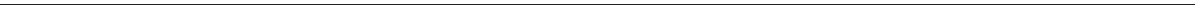
FIGURE 1 | mice are shown in blue and Tgfbr1 M318R / + are shown in yellow. The number of animals per group is indicated. P -values refer to Brown-Forsythe ANOVA, followed by post-hoc test with multiple comparison FDR correction. In panel (C,E) , the error bars represent the 95% Confidence Interval (CI), the dashed line indicates a simple linear-regression of serial echocardiographic measurements of aortic root diameter from 8 to 24 weeks of age; P -value refers to comparison between slopes using the extra-sum-of-squares F -test in GraphPad. (H,I) Systolic blood pressure as measured at 24 weeks of age. P -values refer to Brown-Forsythe ANOVA, followed by post-hoc test with multiple comparison FDR correction.